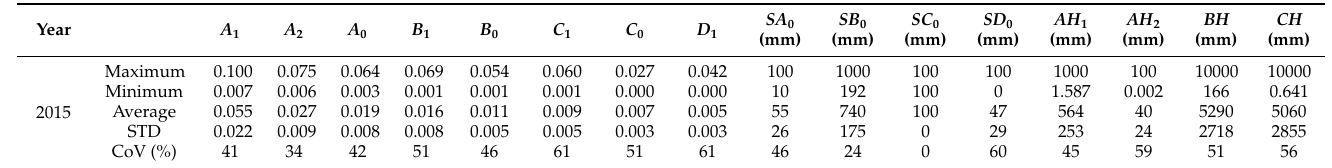
Table 5. Descriptive statistics for tank model parameter sets that were obtained from model calibration. Only parameter sets with an NSE of at least 0.5 were considered.